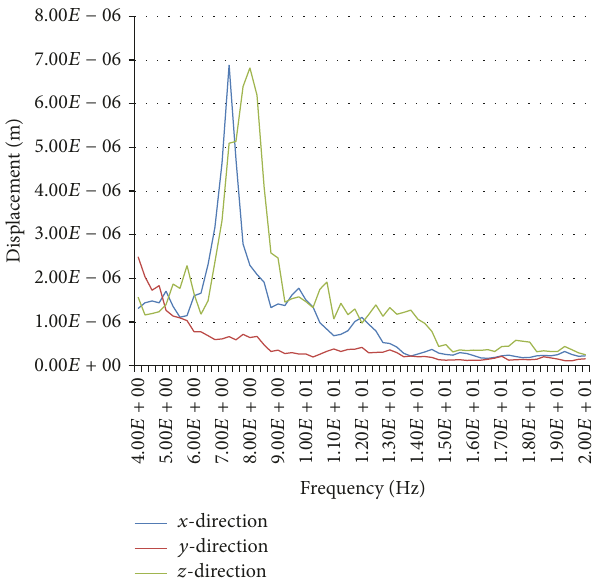
Figure 12: The FFT spectrums of Location 1.